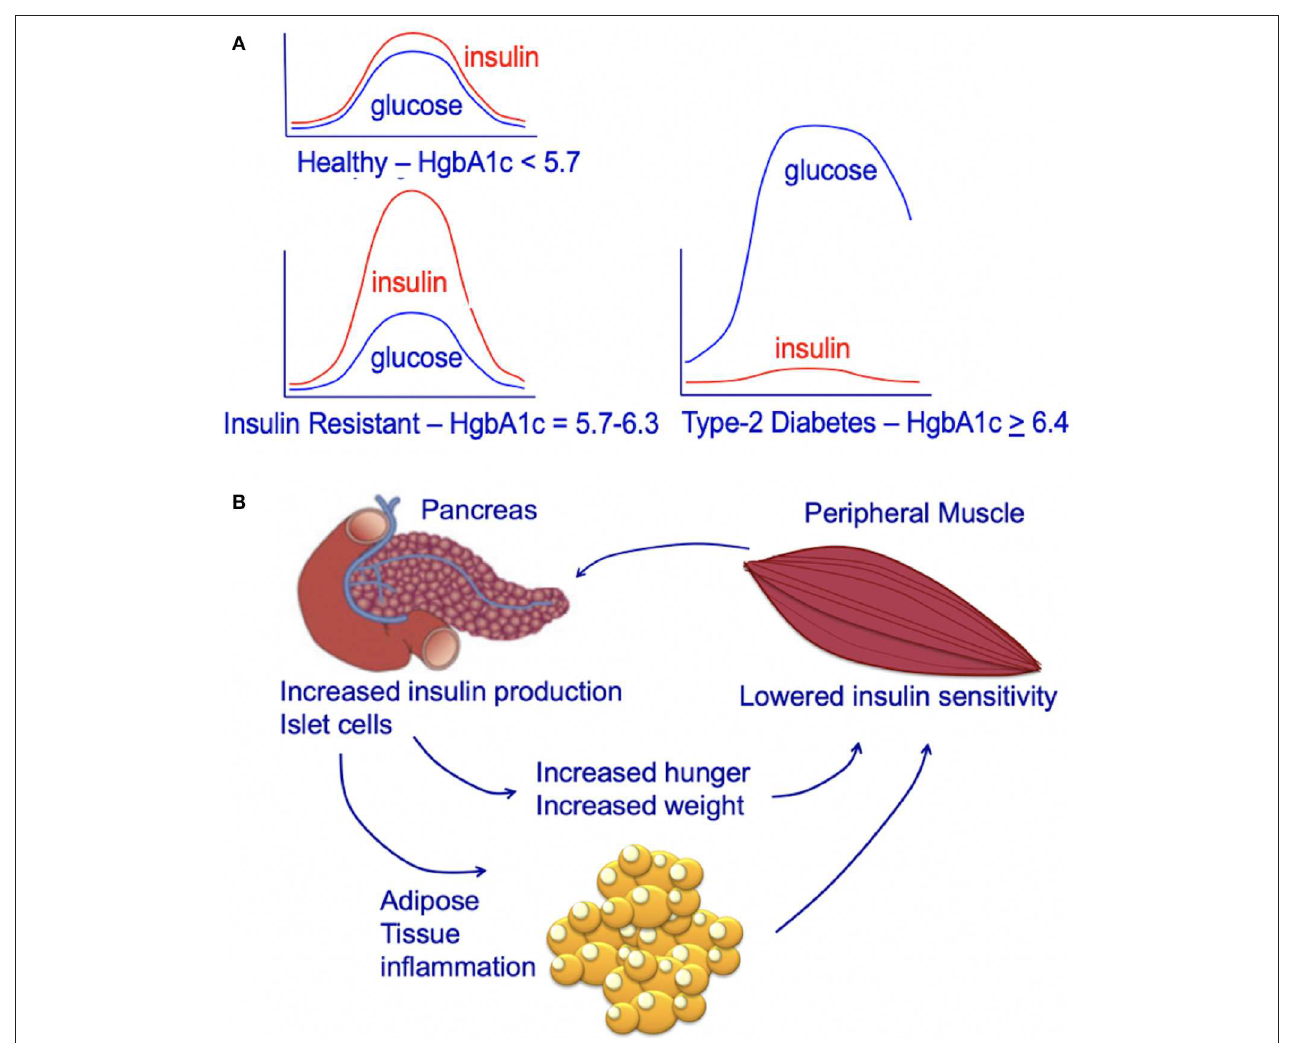
FIGURE 3 | (A) Circulating insulin and glucose levels in healthy individuals (Healthy), insulin-resistant individuals (Resistant), and individuals with type-2 diabetes (Diabetes) at baseline and at 2h after eating. Individuals with type-2 diabetes can experience beta-cell failure and an associated decline in serum insulin levels. This beta-cell failure/decline insulin is highly variable and time-dependent. For an excellent review see Roden and Shulman ( 46). (B) Impact of insulin-resistance on pancreatic islet cells, peripheral muscle, and individual. Insulin resistance in peripheral muscle tissue results in increased insulin demands from the pancreas. Increased circulating insulin drives hunger and increases weight, leading to a positive feedback loop that increases the chance of an individual developing type-2